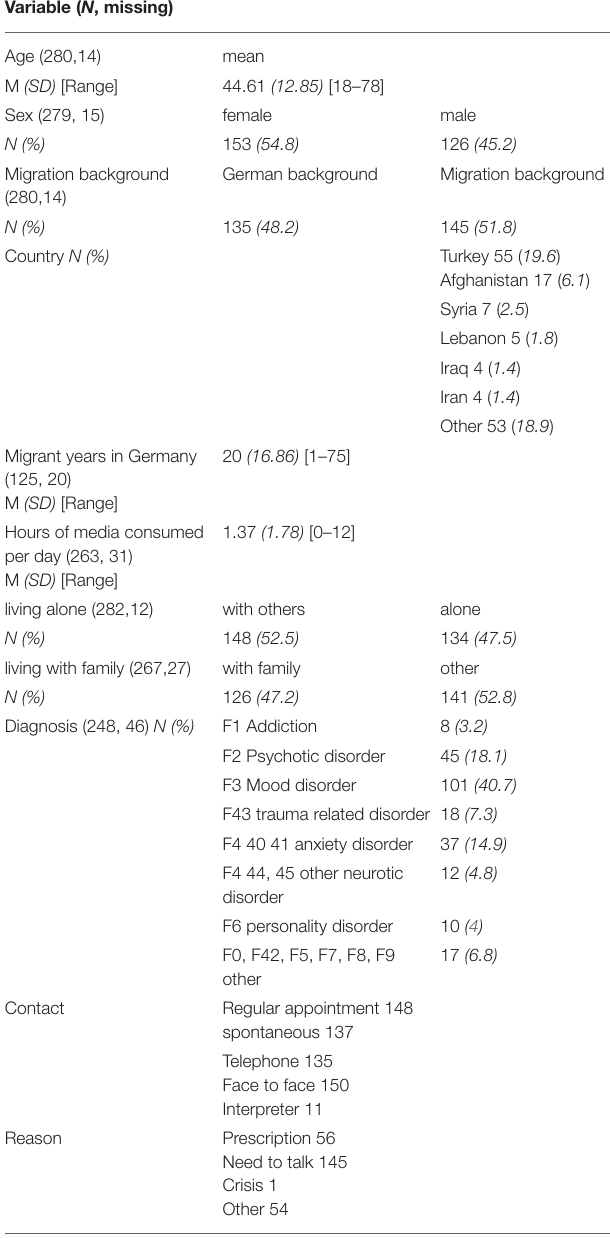
TABLE 1 | Demographic information for survey participants missing data for each group are included. Variable ( N ,